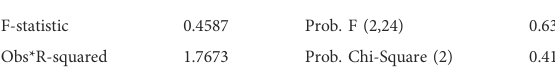
TABLE 3 Breusch-Godfrey Serial Correlation LM Test.